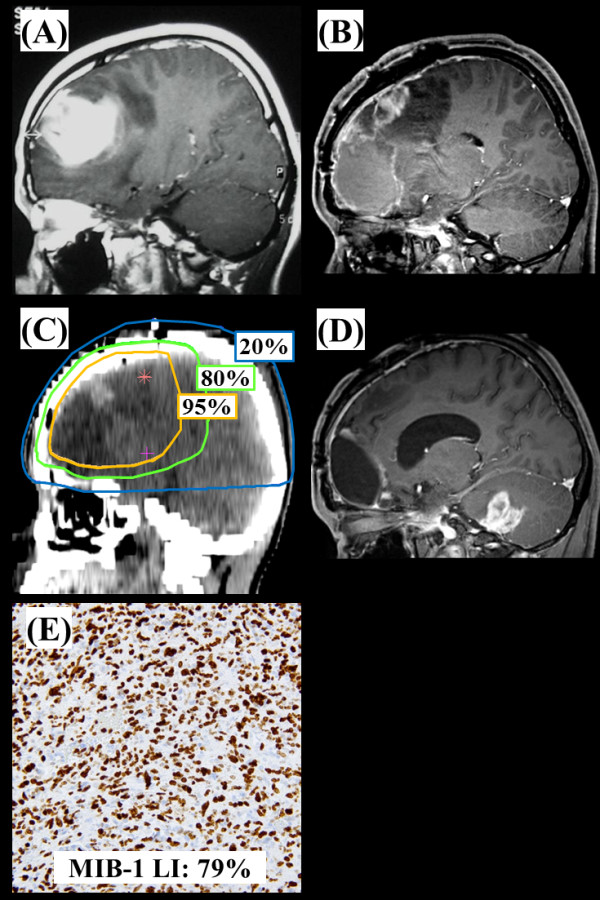
Representative images for the case of GB with higher MIB-1 LI. A
24-years male patient with GB showing a higher MIB-1 LI (79%) that recurred in
the distant region. (A) A postcontrast MR image (T1 weighted) before
surgery (B) A postcontrast MR image (T1 weighted) after a gross total
removal. (C) Treatment planning CT image showing the 95% isodose curve
(yellow), 80% isodose curve (green), and the 20% isodose curve (blue).
(D) A postcontrast MR image (T1 weighted) at 11 months after
completion of radiation showing a recurrence tumor that developed in the
distant. (E) Immunohistochemical analyses (×200).